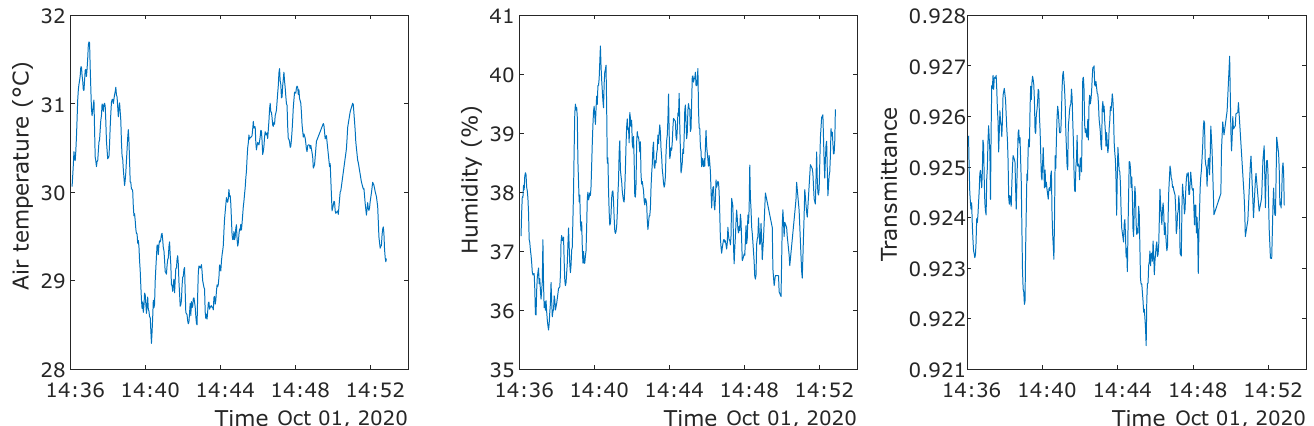
Figure 15. Atmospheric conditions recorded by the weather station on the ground during the flight. The transmittance of the atmosphere was estimated by using Equation